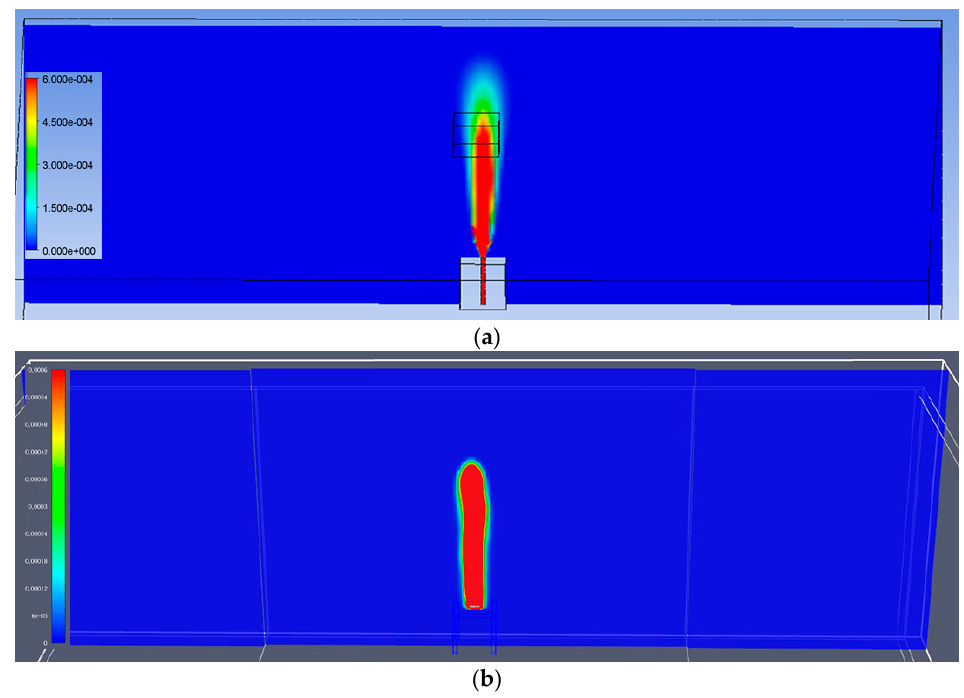
Figure 14. Comparison of hydrogen dispersion for 1.5% concentration of LEL for time 10 s: ( a ) propane release calculated with Ansys software; ( b ) propane release calculated with FDS software. Analysis of hydrogen distribution after 25 s indicated that the 1.5% LEL area was